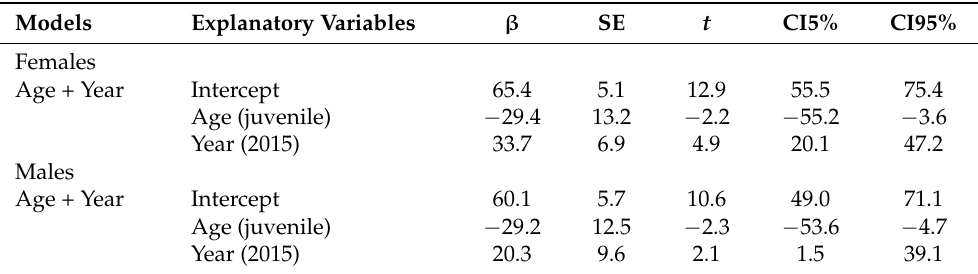
Table 4. Explanatory variables (category), estimates ( β ), standard errors (SE), t -values ( t ) and confidence intervals (CI5% and CI95%) of the best models assessing the effects of age, lactation status and year on the diversity of mushrooms consumed by male and female white-tailed deer on Anticosti Island (Qu é bec, Canada). Intercept categories are adult and 2014.